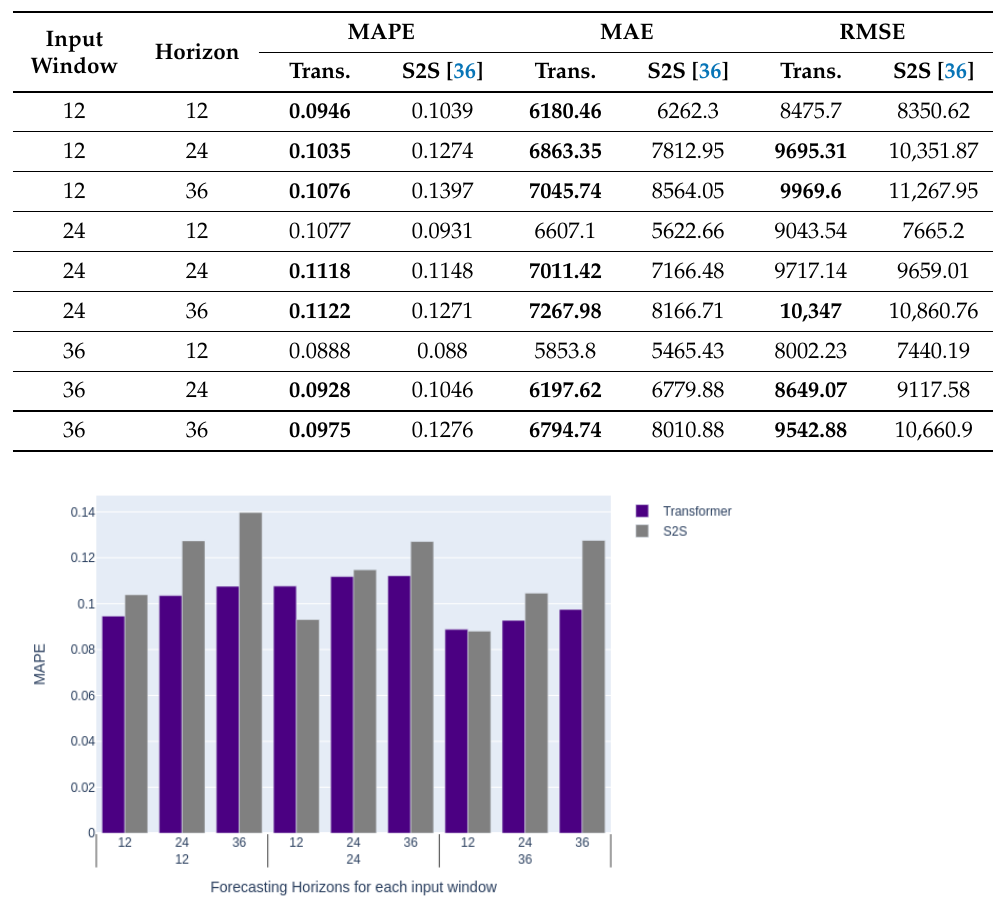
Table 1. Average accuracy over the streams for each combination of input size and forecasting horizon. The bold numbers indicate where transformers outperform S2S.